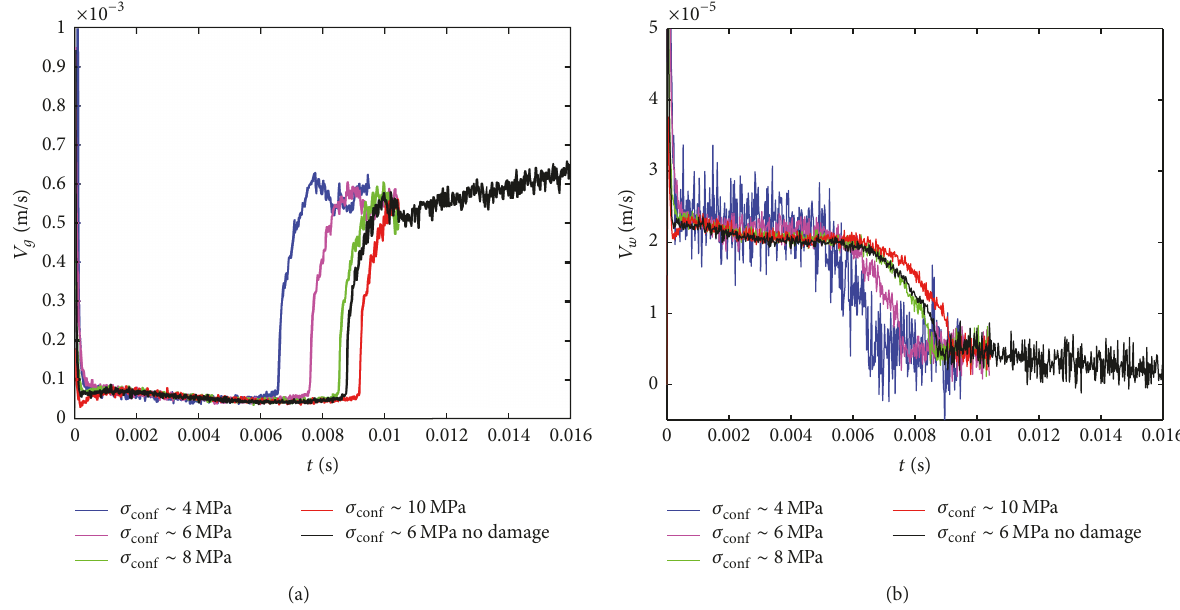
Figure 12: Water (a) and gas (b) seepage velocities during drainage as functions of time for various confining stresses.